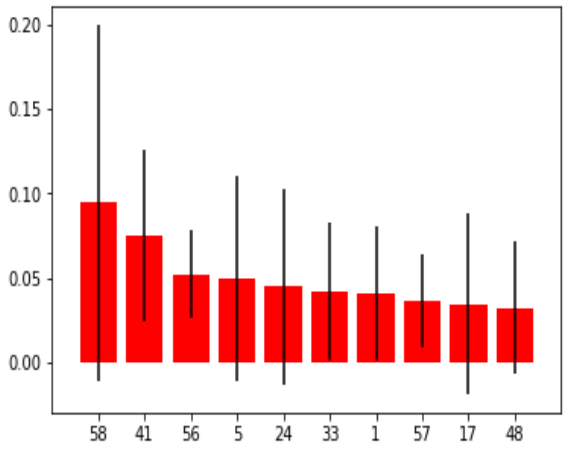
Figure 5. (a) Aspect, (b) Slope (c) represents average Land Surface Temperature (LST) map of the Study Area